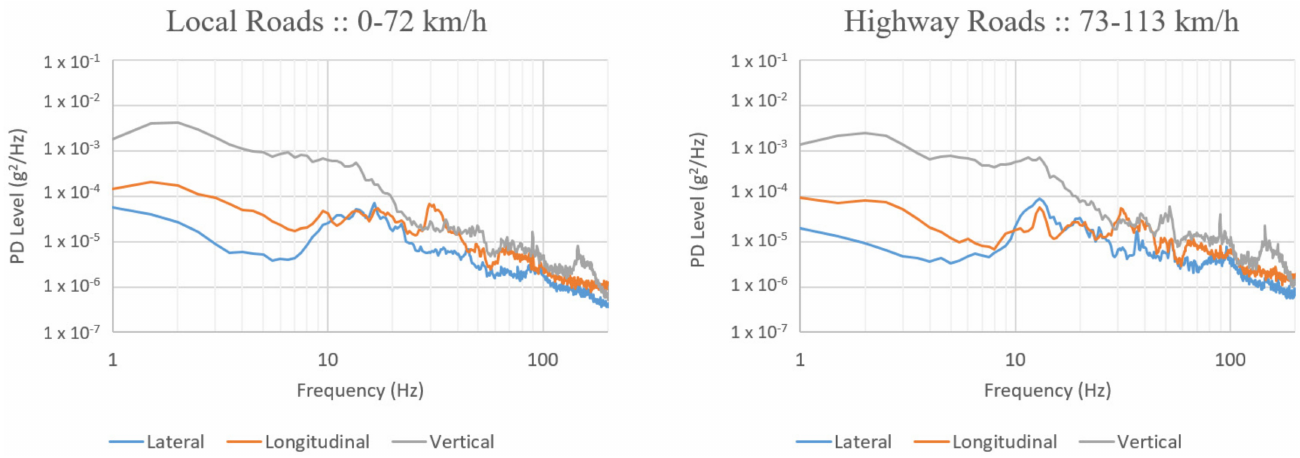
Figure 2. PSD plots for triaxial vibration of the Camry sedan.